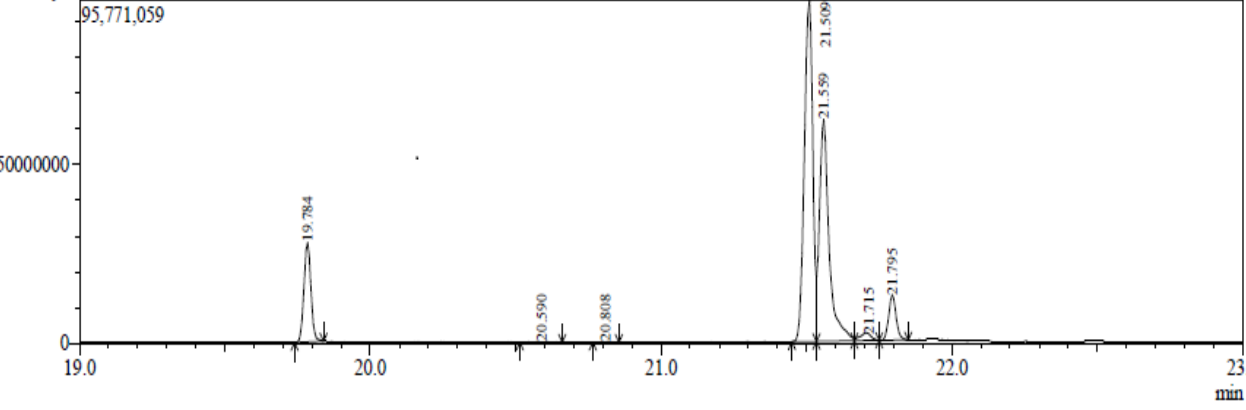
Figure 8. GC − MS of synthesised biodiesel.